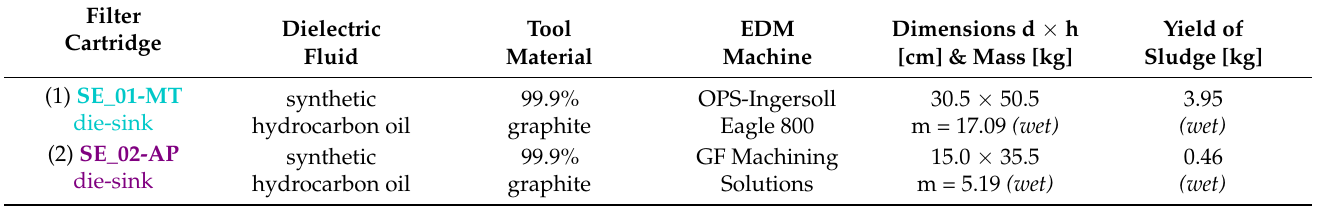
Table 3. Overview of investigated filter cartridges.